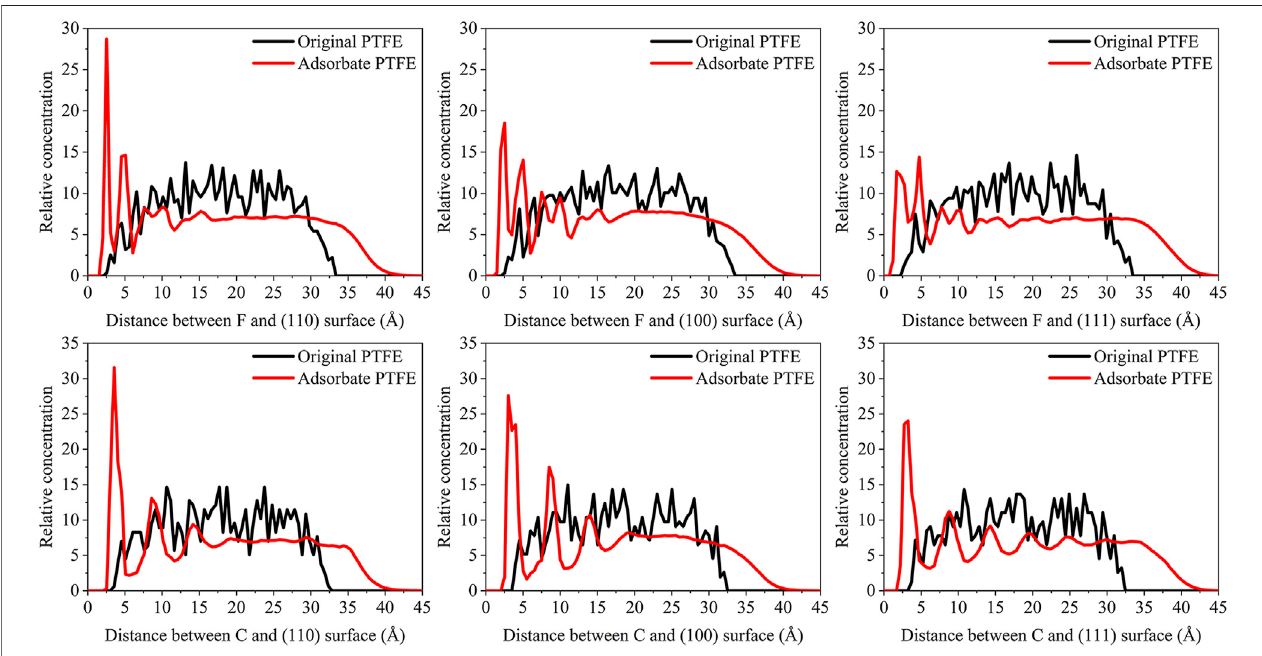
FIGURE 3 | Concentration distribution of F and C atoms along z-axis for the (110)/PTFE (100)/PTFE, and (111)/PTFE interface systems.